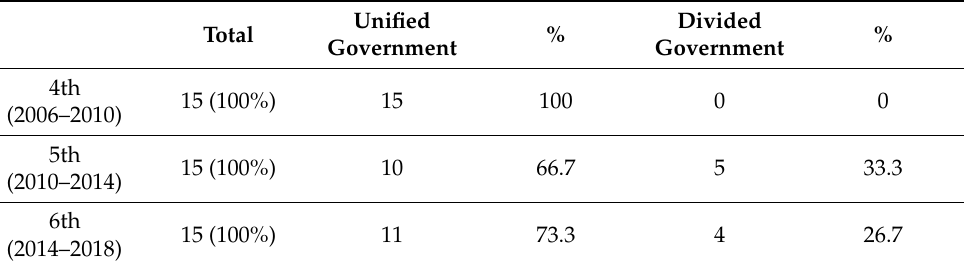
Table 1. Unified and divided local government in